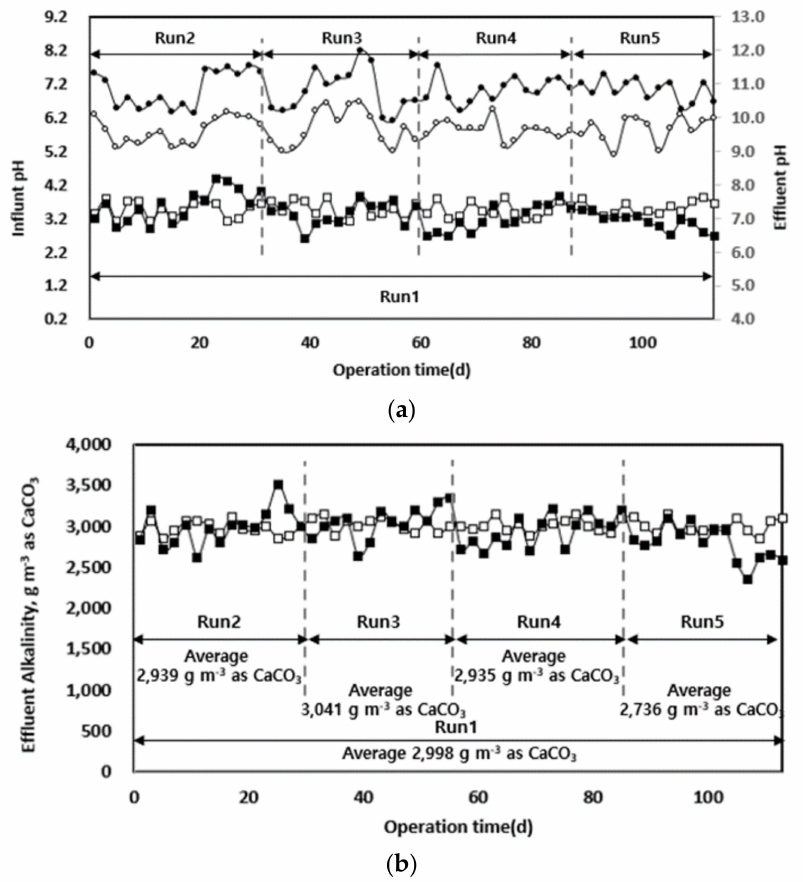
Figure 5. Changes in pH ( a ) and alkalinity ( b ) according to operation